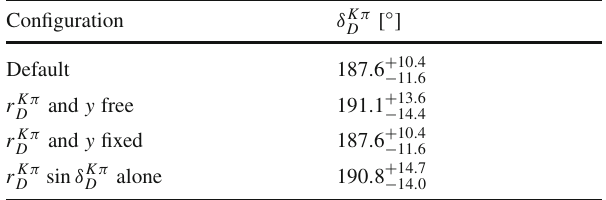
Table 9 Results for δ K π the